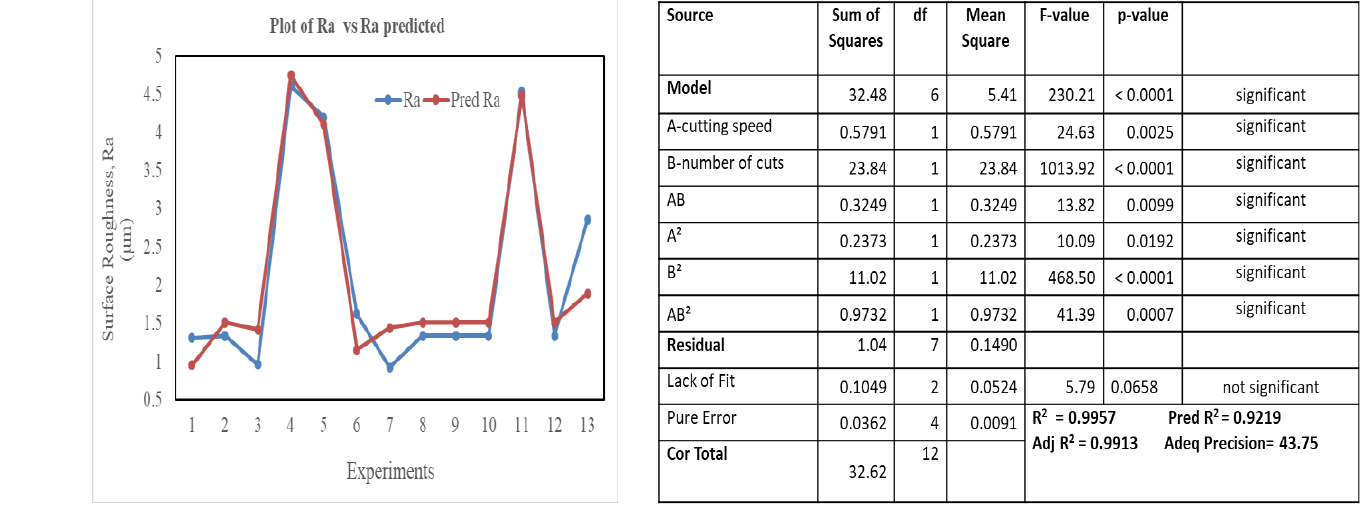
Figure 16. Plot of Ra vs predicted Ra, ANOVA model for Ti-6Al-7Nb.